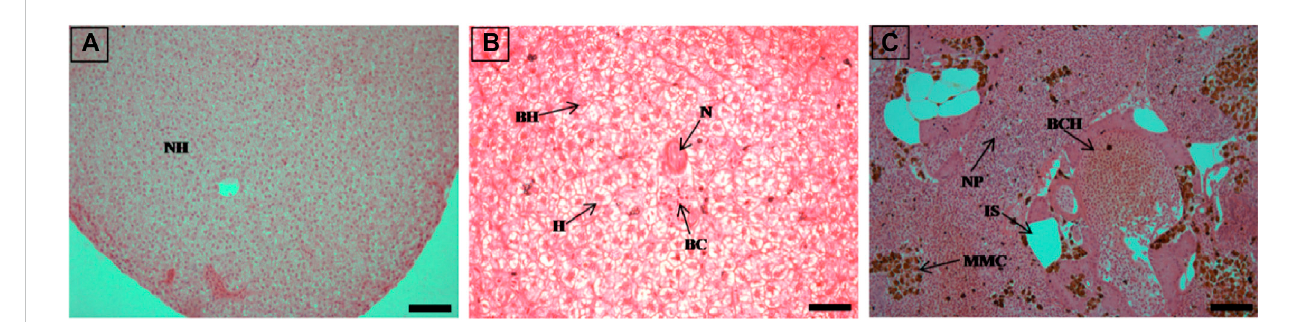
FIGURE 2 Thehistologicalsections(4 µm)oflivertissuesfromcontrol fi shshowingnormalhepatocytes (A) andEB-administeredgoldenmahseeron11thday (B,C) of EB-medication. The histological changes in liver tissues of fi shes fed with EB doses (B) at 250 μ g/kg fi sh/day showing hepatocyte hypertrophy (H), binucleated hepatocytes (BH), blood congestion (BC), necrosis (N); (C) at 500 μ g/kg fi sh/day showing large melanomacrophage centres (MMC), blood congestioninhepatic veins (BCH), increased sinusoids (IS),nuclear pyknosis (NP). The H&E stainedsectionsare visualized atmagni fi cationof 200 (A and C) and 400X (B) under inverted light microscope (Olympus IX53, Canada). The scale bar value depicted in the right bottom corner is 20 µm (B) and 40 µm (A and C) .